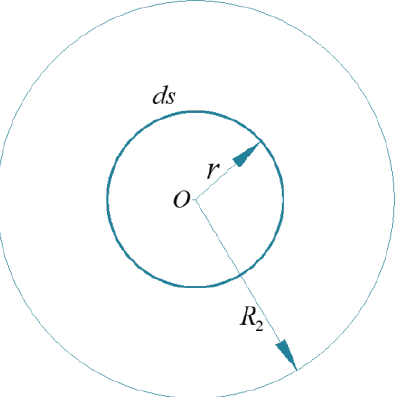
Figure 4. Unfolding plane of the contact surface between the top plate and bottom basin of UHS.